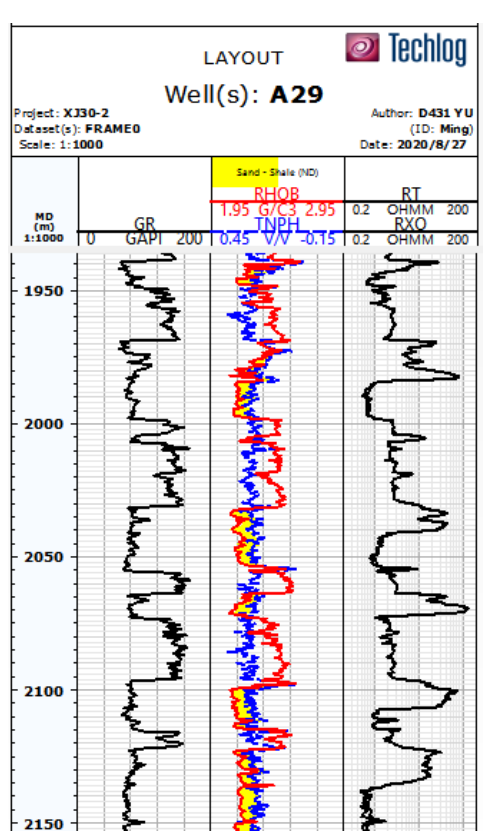
Fig. 2 Logging curve of well